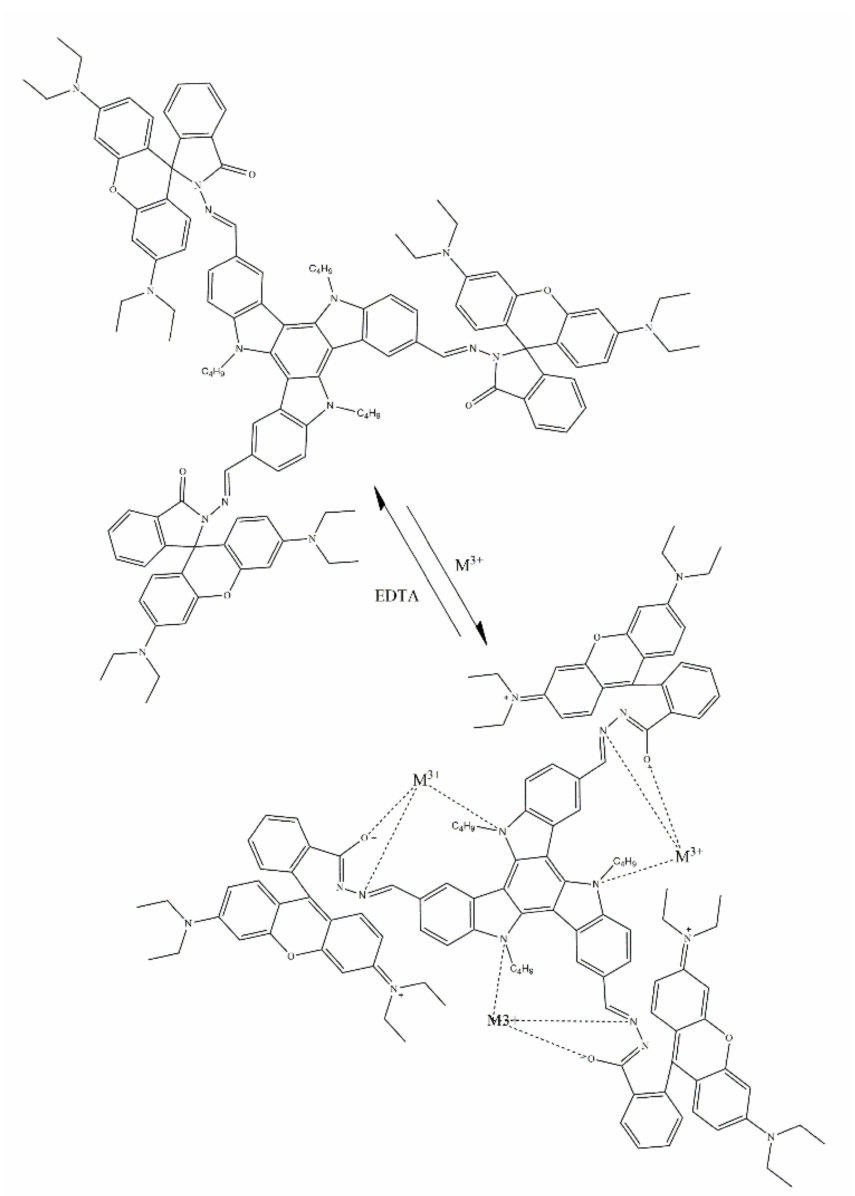
Figure 62. The proposed binding mechanism of TAT-ROD (Table 4, No. 15) to Fe 3+ , Cr 3+ and Al 3+